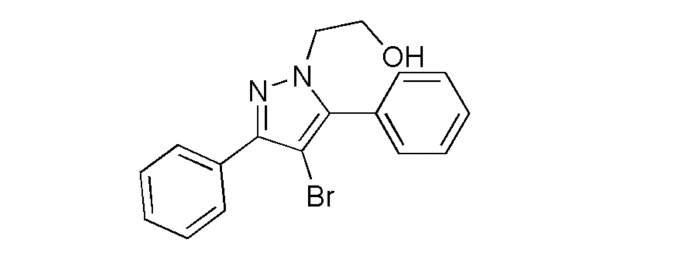
Figure 1. Chemical structure of